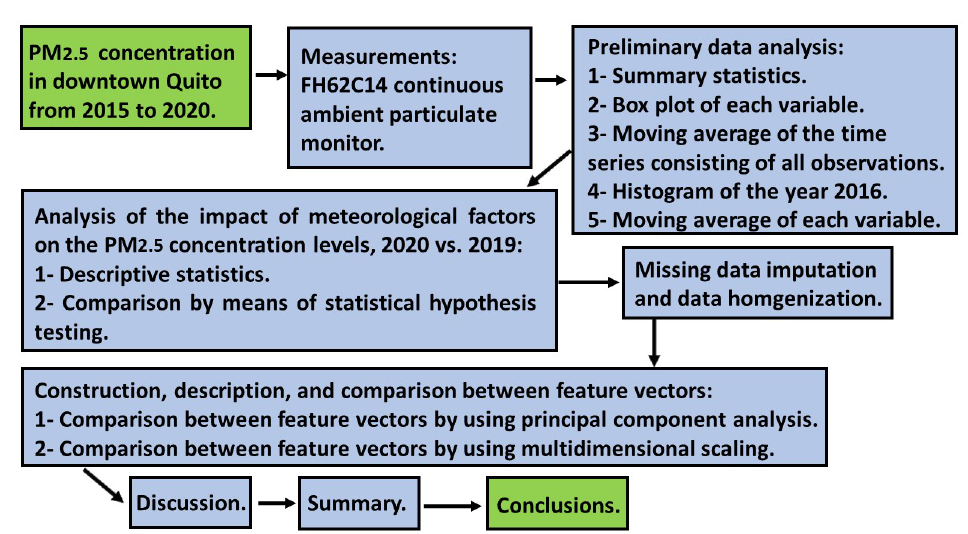
Figure 1. Flowchart of the analysis process that was followed in this